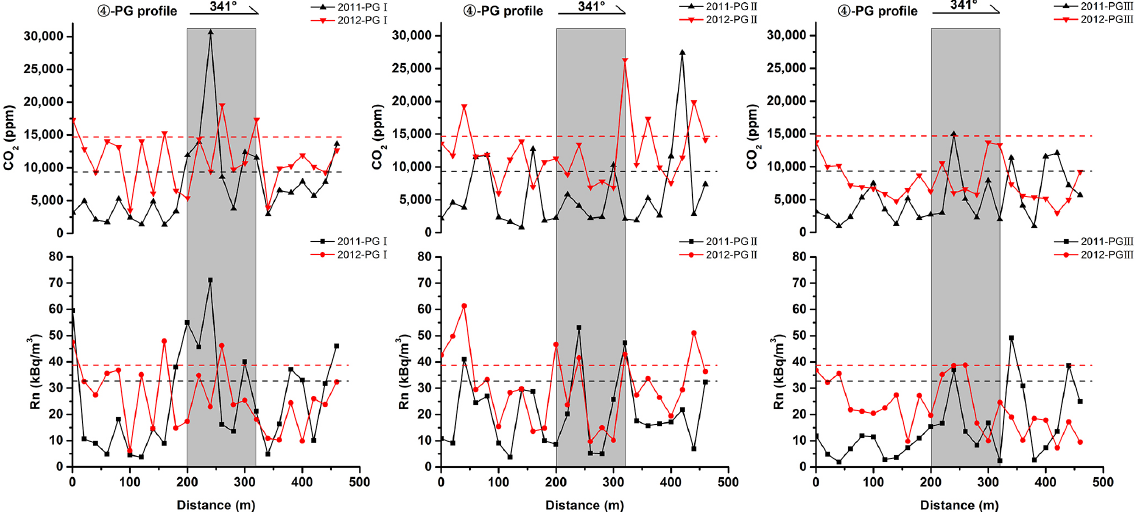
Figure 7. Rn and CO 2 concentrations along the PG profile across the Xiadian Fault. The shaded bar represents the location of the fault. The black and red dotted lines represent the anomaly threshold of soil gas in 2011 and 2012, respectively. The arrow at the top (with number above) represents the direction of the